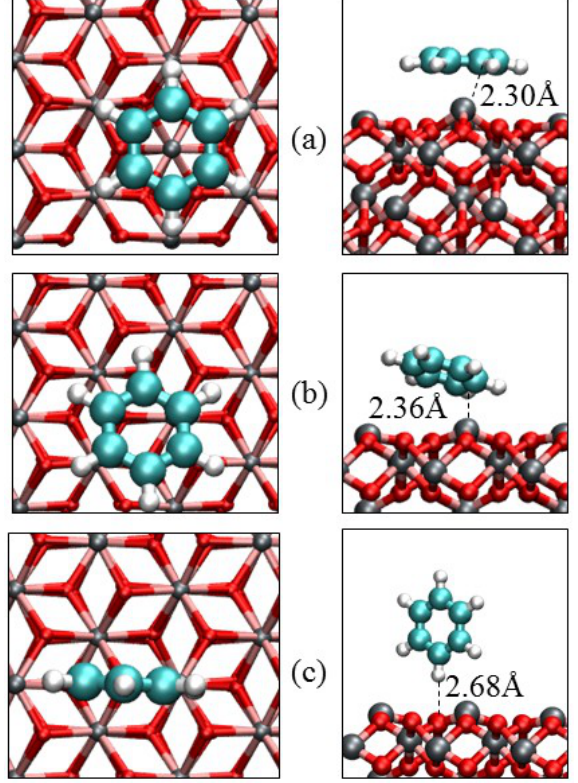
Figure 10. Relaxed adsorption geometries of the benzene on α-Fe ( b ) slant and ( c ) vertical adsorption modes respectively. The top ( left ) and side ( right ) views are shown. Color scheme: Fe = grey; O = red; C = green and H =